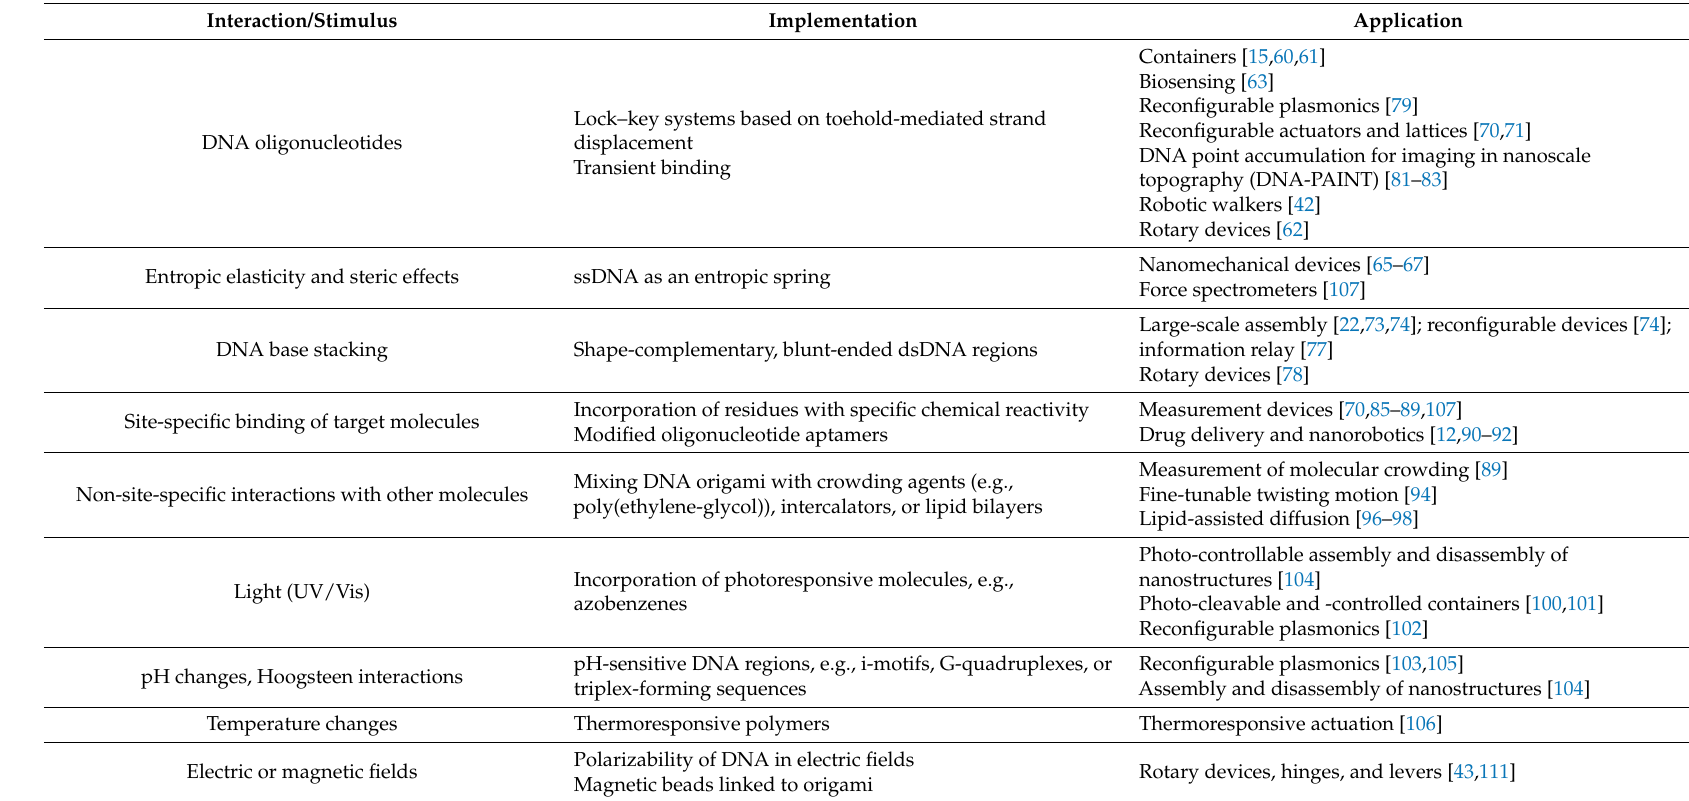
Table 1. Summary of the reviewed types of DNA origami